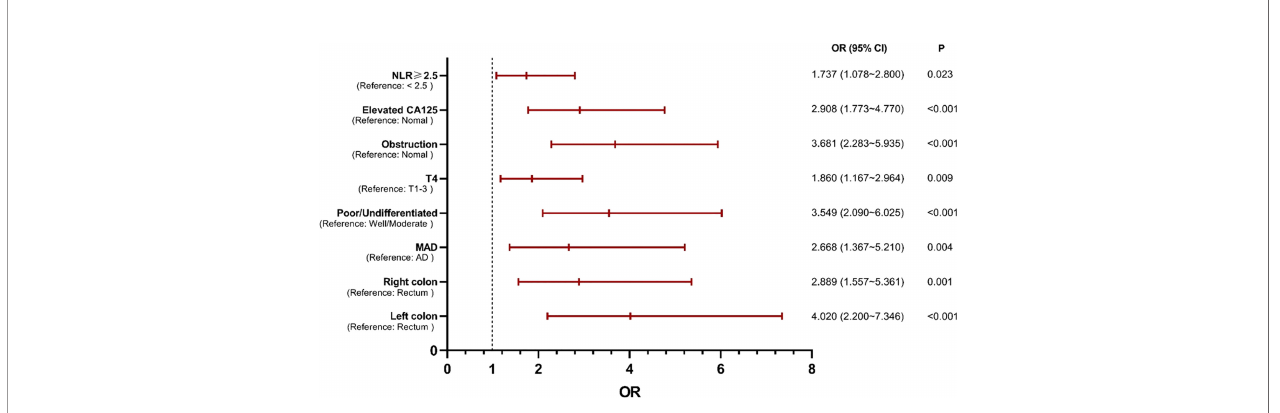
FIGURE 1 | Independent predictors of occult PM identi fi ed by multivariate analysis. NLR, neutrophil-to-lymphocyte ratio; MAD, mucinous adenocarcinoma; AD,